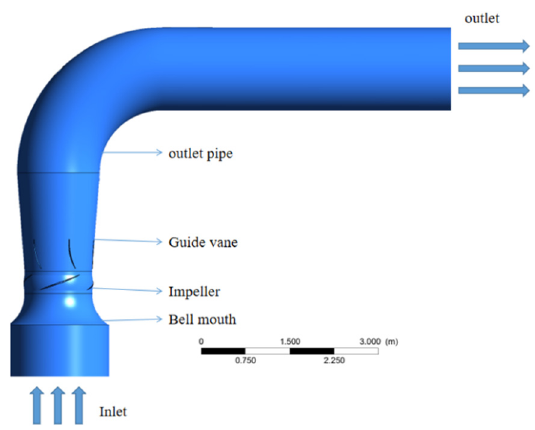
Figure 1. 3D model of the axial flow pump.